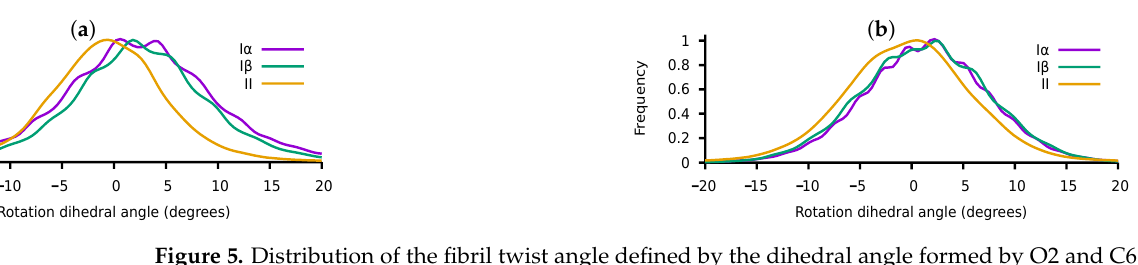
Figure 5. Distribution of the fibril twist angle defined by the dihedral angle formed by O2 and C6 centers from two subsequent D-glucose. Panel ( a ) shows AA-MD representation and bottom panel ( b ) for the CG-MD